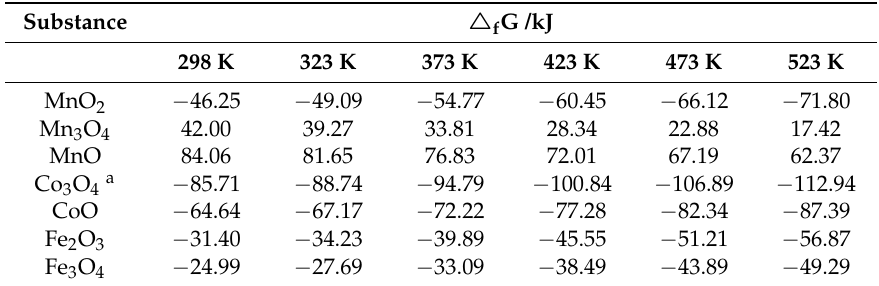
Table 7. Gibbs free energy for the reaction between M x O y and NH 3 under different